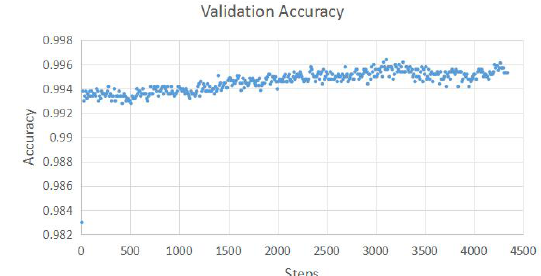
Figure 6. Validation accuracy of the proposed